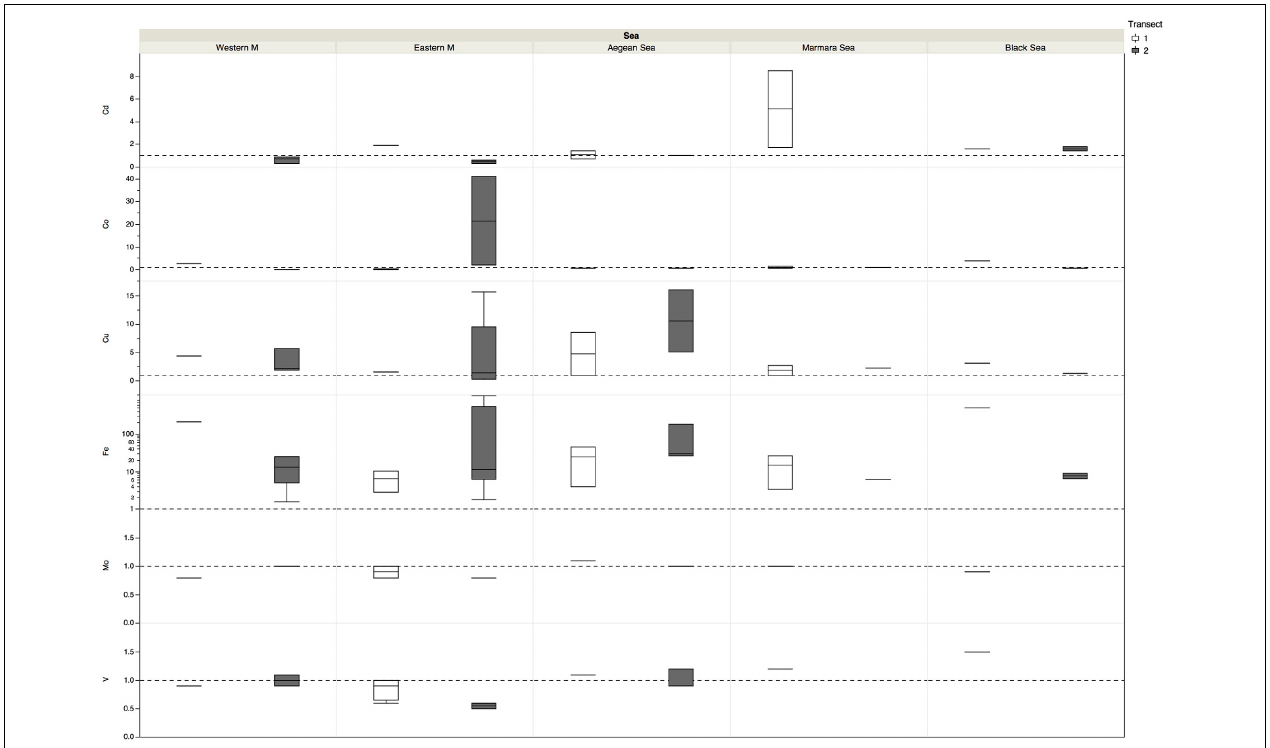
FIGURE 3 | Enrichment factors calculated for Cd, Co, Fe, Mo and V in the SML with respect to the subsurface seawater. Dashed line indicates an enrichment factor of 1.